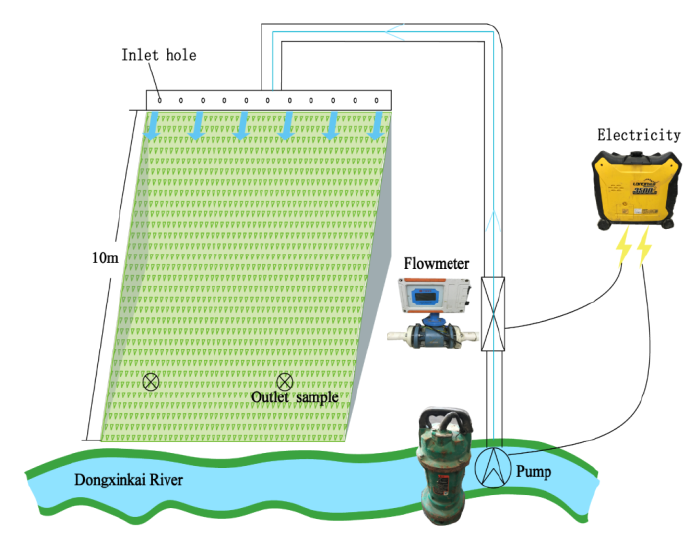
Figure 3. Field experiment design diagram.